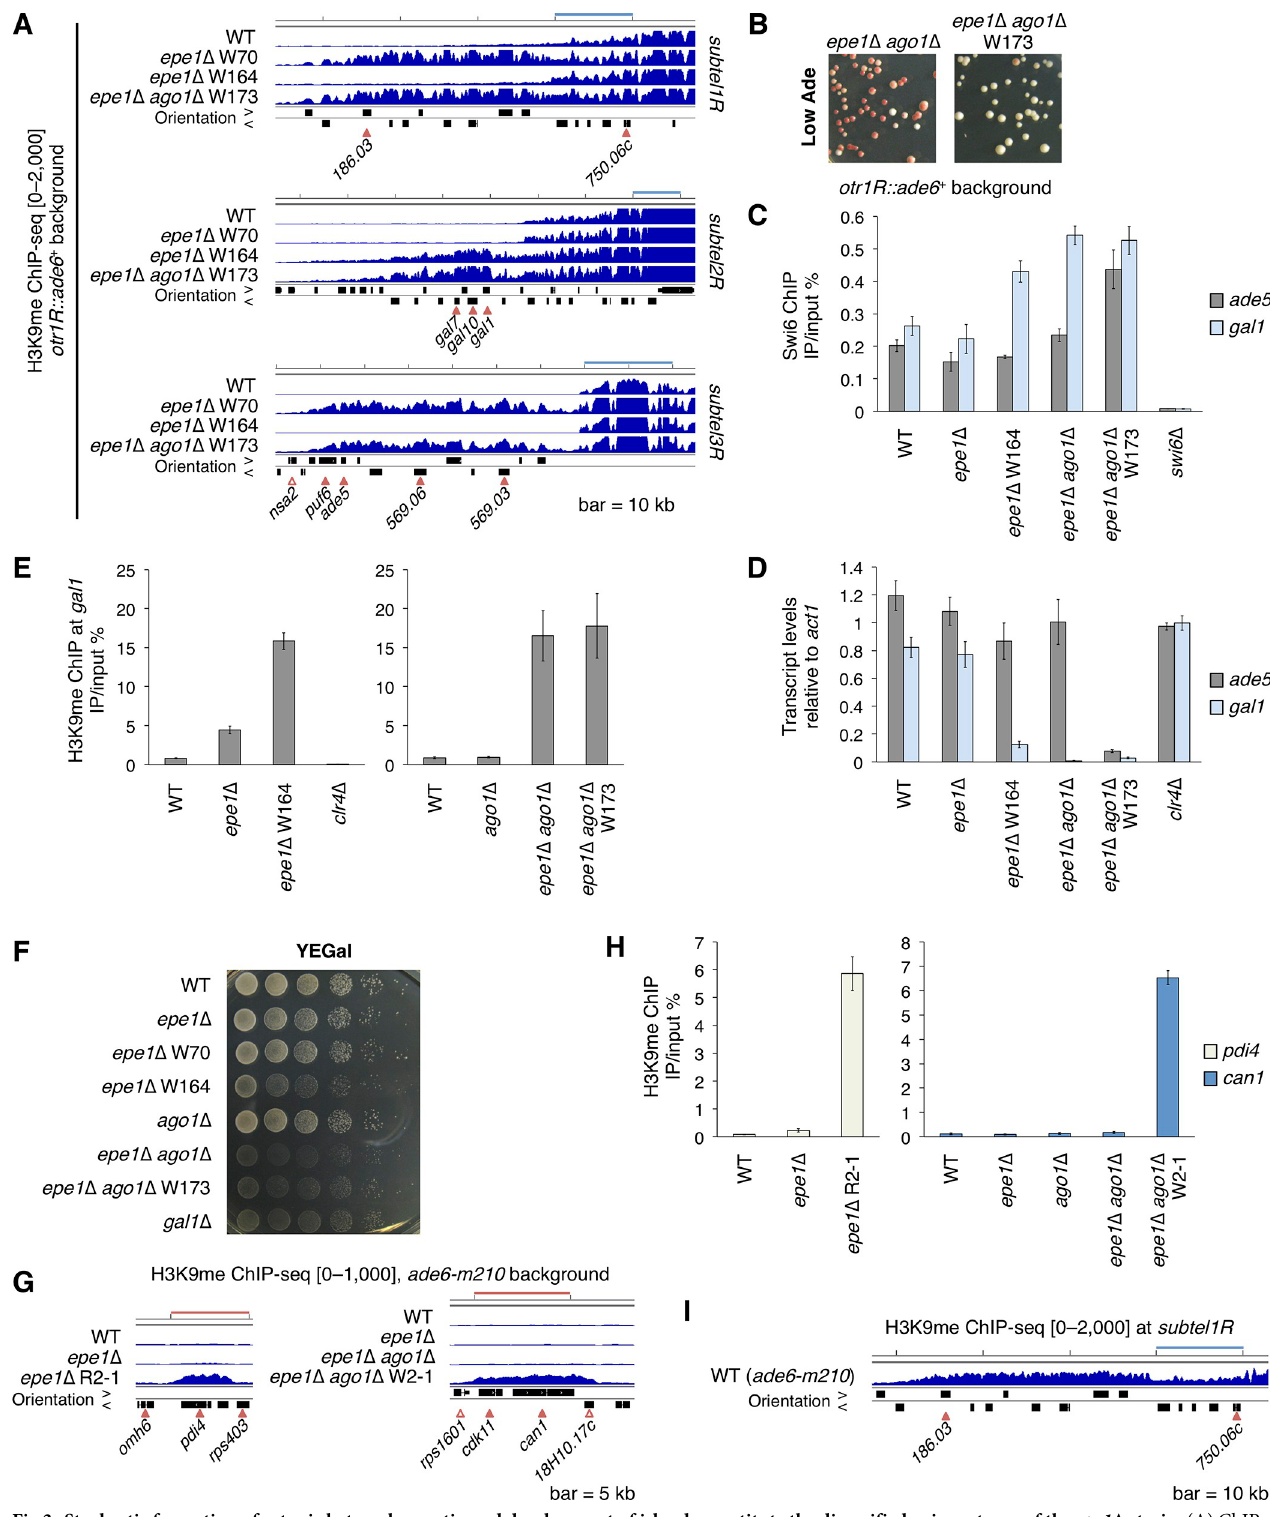
Fig 3. Stochastic formation of ectopic heterochromatin and development of islands constitute the diversified epigenotypes of the epe1 Δ strain. (A) ChIP- sequencing analysis of H3K9me in otr1R :: ade6 + strains. Three right subtelomeric regions are shown. The vertical range of the graphs is indicated on the left. Bar, 10 kb; open arrowhead, essential genes based on the S . pombe gene database; filled arrowhead, nonessential genes; orientation > , left to right; orientation